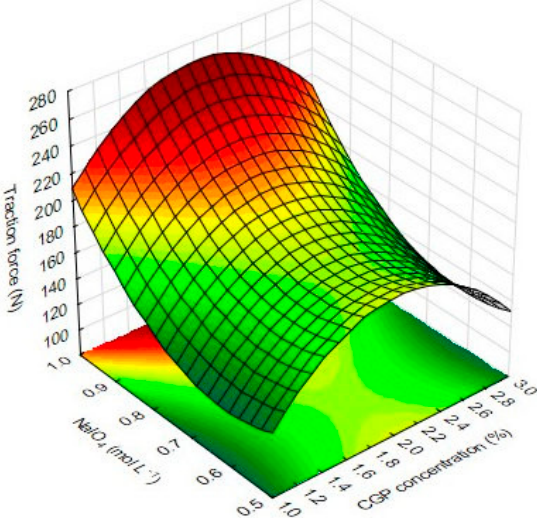
Figure 8. Response surface plots for traction force results of CGP/PVA films as function of the significant factors.